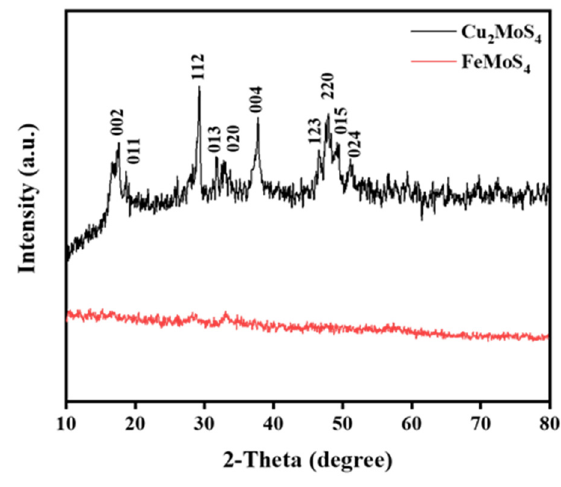
Figure 1. XRD patterns of as-prepared Cu 2 MoS 4 and FeMoS 4 .